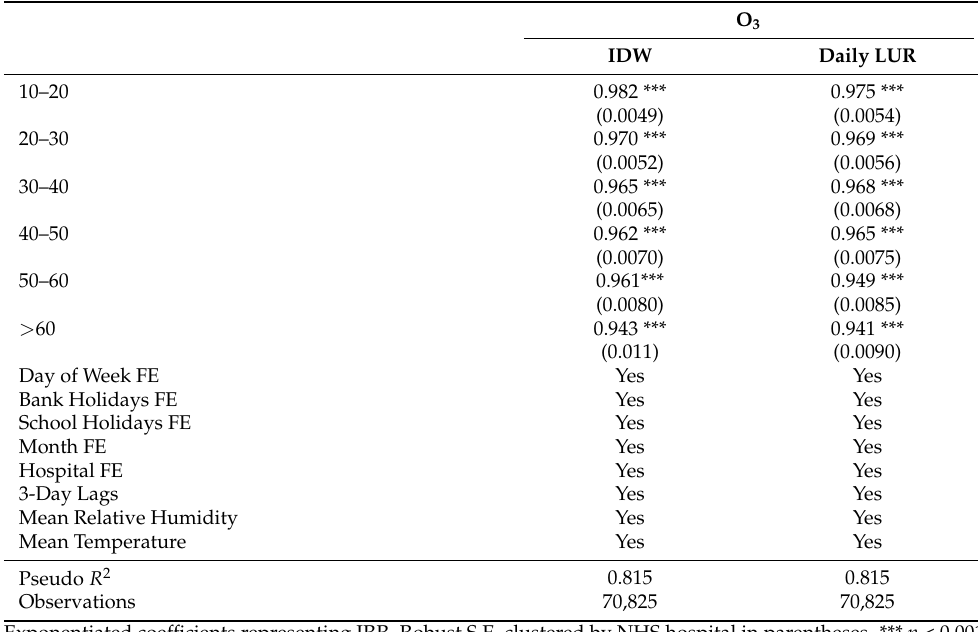
Table A4. Incidence risk ratios (IRRs) of the effect of exposure on a day in a given range of O 3 , relative to a day in the 0–10 µgm − 3 range. This represents the contemporaneous effect of O 3 ( β p ). A value of 1 represents no change. Estimates are shown for two pollution exposure assignment methods: inverse distance weighting (IDW) and daily land use regression (daily LUR).